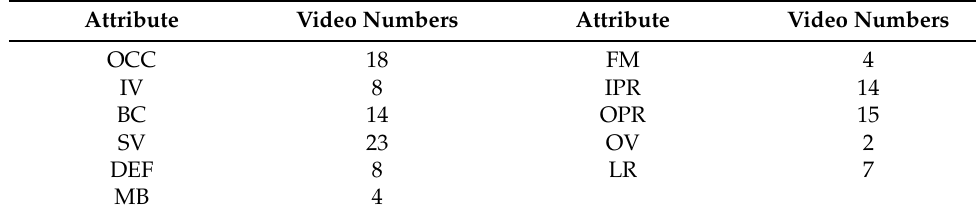
Table 2. Video numbers information of each challenge attribute in the testing